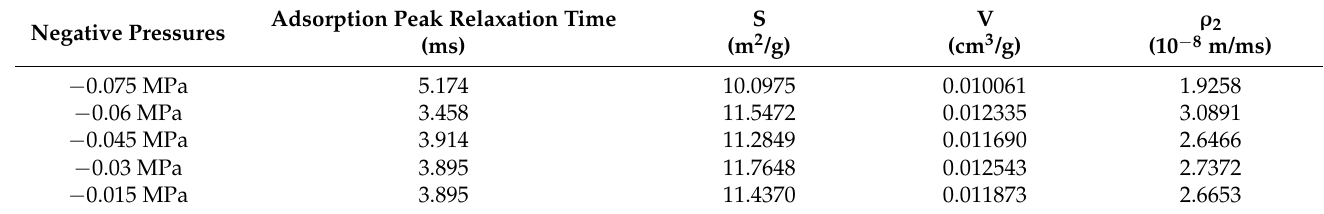
Table 5. Calculation data of surface relaxation rate of the low-rank coal